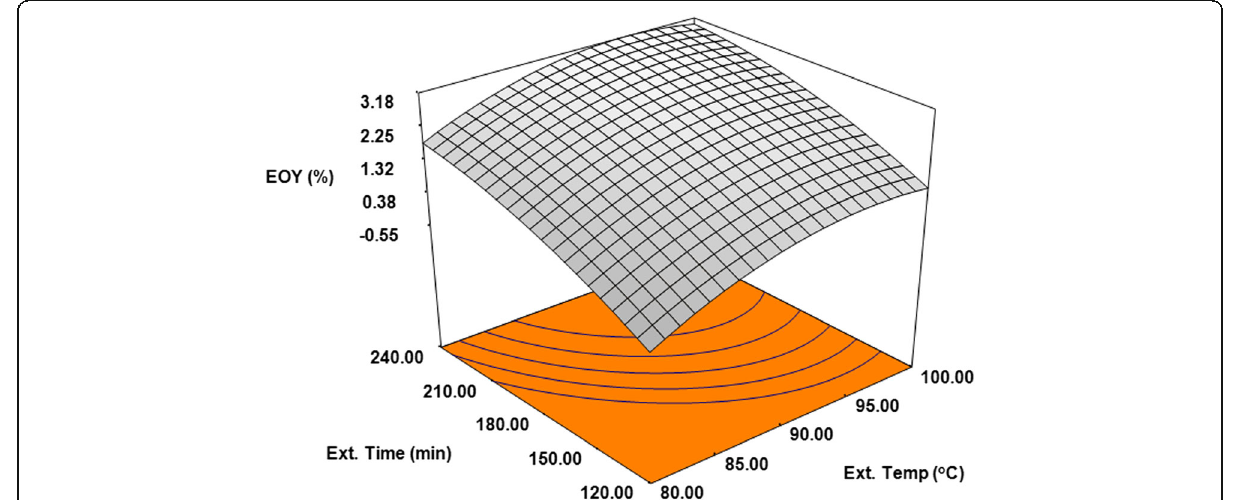
Fig. 1 Response surface plot of the effect of extraction temperature and extraction time on essential oil